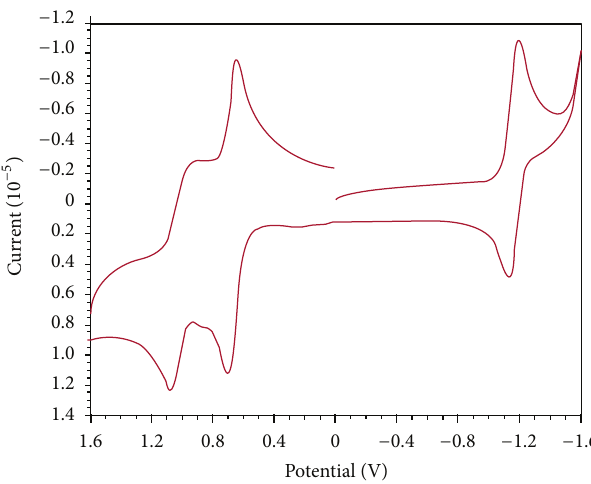
Figure 3: Cyclic voltammogram of N,N 󸀠 -diphenylbenzene-1,4- diamino-1,8-naphthalic anhydride (EE-1).